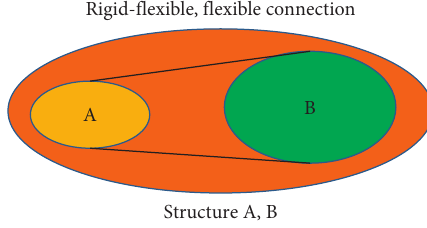
Figure 1: The internal relations of dynamic substructures.